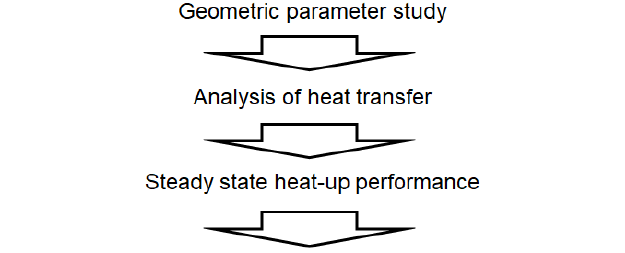
Figure 3. Chronological sequence of investigations.